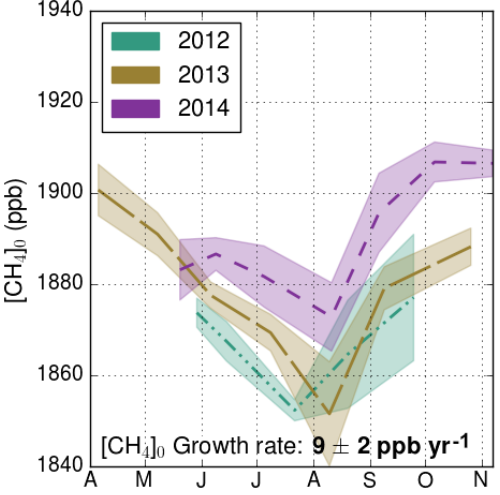
Figure 5. The mean tropospheric [CH 4 ] 0 estimated from profiles (shaded areas indicate 1 σ ). Values are centered on the mean mea- surement